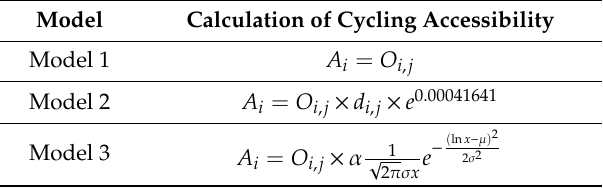
Table 2. Calculation of Cycling Accessibility in Three